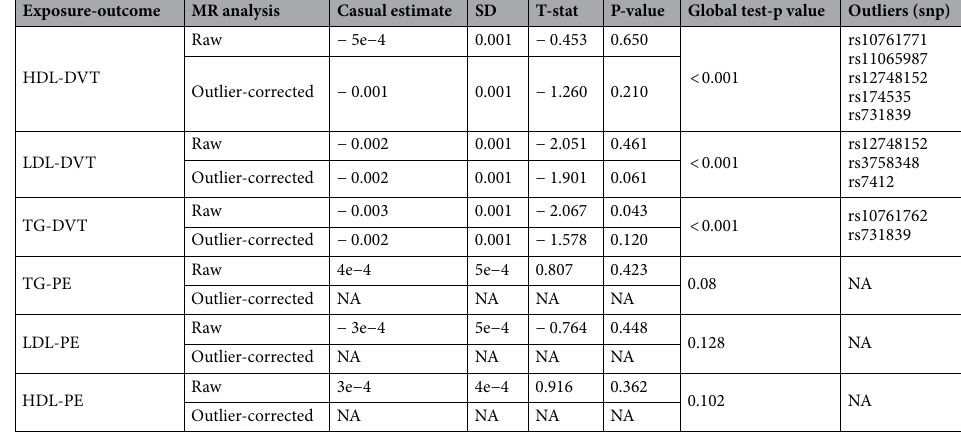
Table 2. MR-Presso results (classical lipids—VT). SD standard deviation, SNP single nucleotide polymorphism, MR-PRESSO MR-Pleiotropy Residual Sum and Outlier method, PE pulmonary embolism,